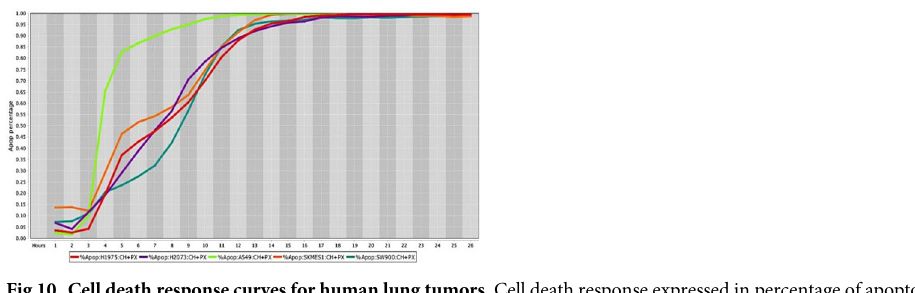
Fig 10. Cell death response curves for human lung tumors. Cell death response expressed in percentage of apoptosis in human lung cancer cell lines (H1975- red line, H2073- purple line, A549- neon green line, SKMES1- orange line, SW900- dark green line exposed to CT at 20 μ M, HO-3867 at 10 μ M, and PX-478 at 25 μ M concentration.